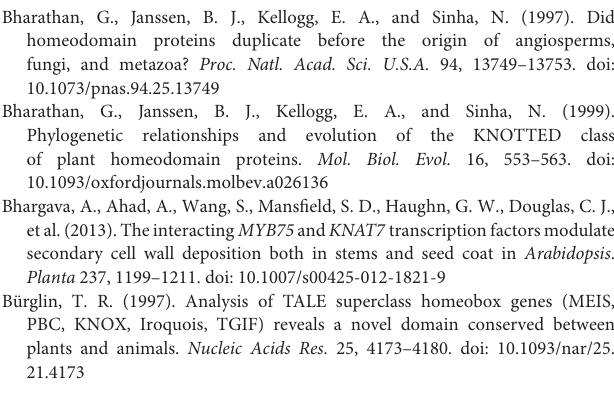
Supplementary Figure 2 | Phylogenetic tree of KNOX gene families in selected species. Tree was constructed using MrBayes as described in Section Materials and Methods. Posterior probabilities are shown at critical nodes. Supplementary Figure 3 | Algae sequences group to classes I KNOX proteins—Alignment. Alignment of selected KNOX proteins to illustrate relationship of the algae sequences to class I. Positions shared between algae and class I are highlighted with green arrows on top. Alignment in this figure has been simplified such that unreliable gapped regions in the original alignment have been removed. Supplementary Figure 4 | Pairwise sequence identity of full-length KNOX proteins. Species analyzed were Physcomitrella patens , Selaginella moellendorffii , Oryza sativa , Zea mays , Arabidopsis thaliana , Populus trichocarpa , and Glycine max. The box plot shows the median (black line), interquartile range (box), and maximum and minimum scores (whiskers) of each data set. Outliers are shown as circles outside of the whiskers. Supplementary Figure 5 | Grouping of plant proteins in KNAT subclasses. Phylogeny of selected plant species based on MrBayes using 84 KNOX protein sequences (The same tree was also used for PAML analysis). Species are Physcomitrella patens , Selaginella moellendorffii , Oryza sativa , Zea mays , Arabidopsis thaliana , Populus trichocarpa , and Glycine max. Nodes indicated with an orange circle have posterior probabilities in the range 0.5–0.9. All other nodes have posterior probabilities > 0.9. Supplementary Figure 6 | Expression of the KNOX genes in Physcomitrella patens and Selaginella moellendorffii . The blue box indicates positive detection of gene expression in the corresponding tissues. Supplementary Figure 7 | Glycine max expression data. The figure has the same data as in Figure 6 , but with information on sample identity. See also Supplementary Table 2 , an Excel spreadsheet of the quantitative